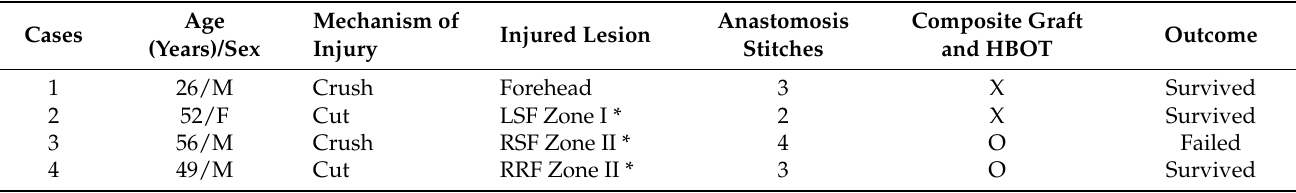
Table 2. Patients’ baseline characteristics and operative